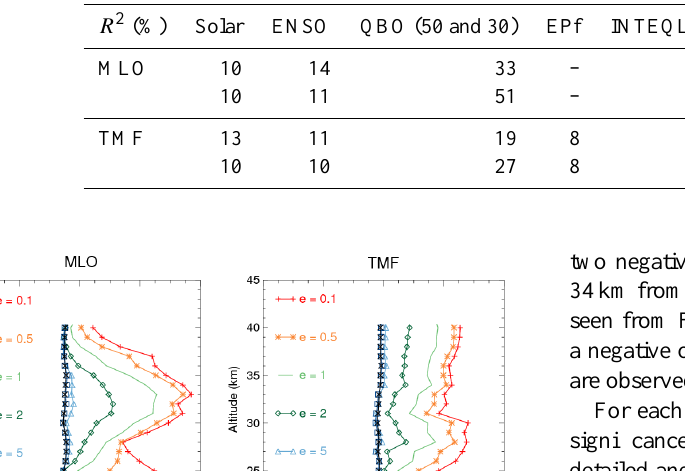
Table 3. Proxies and mean explained variance (noted if over or equal to 5%) over all altitude bins (lidar values are for each station on the first line and satellite below).